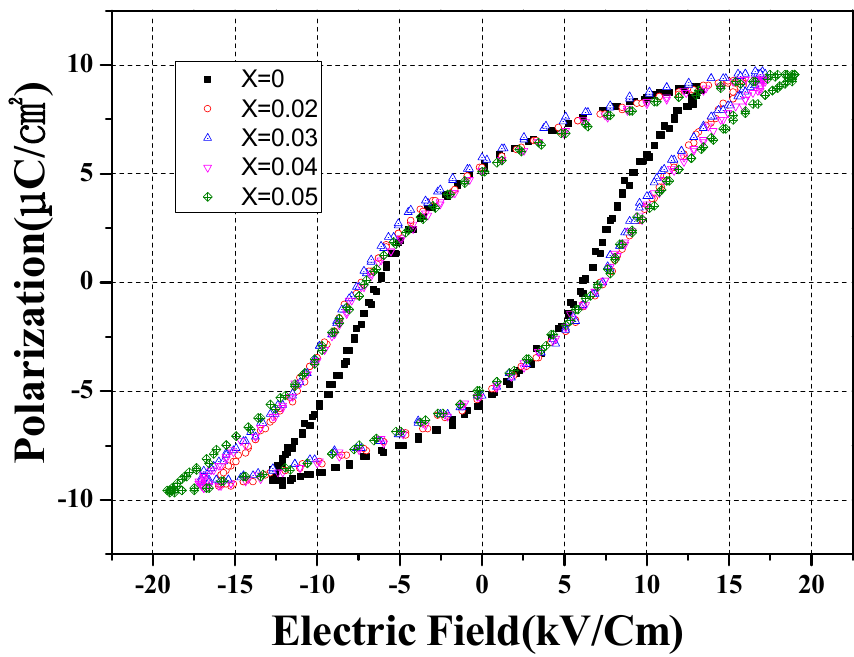
Figure 7. Piezoelectric constant (d 33 ) of specimens with x.